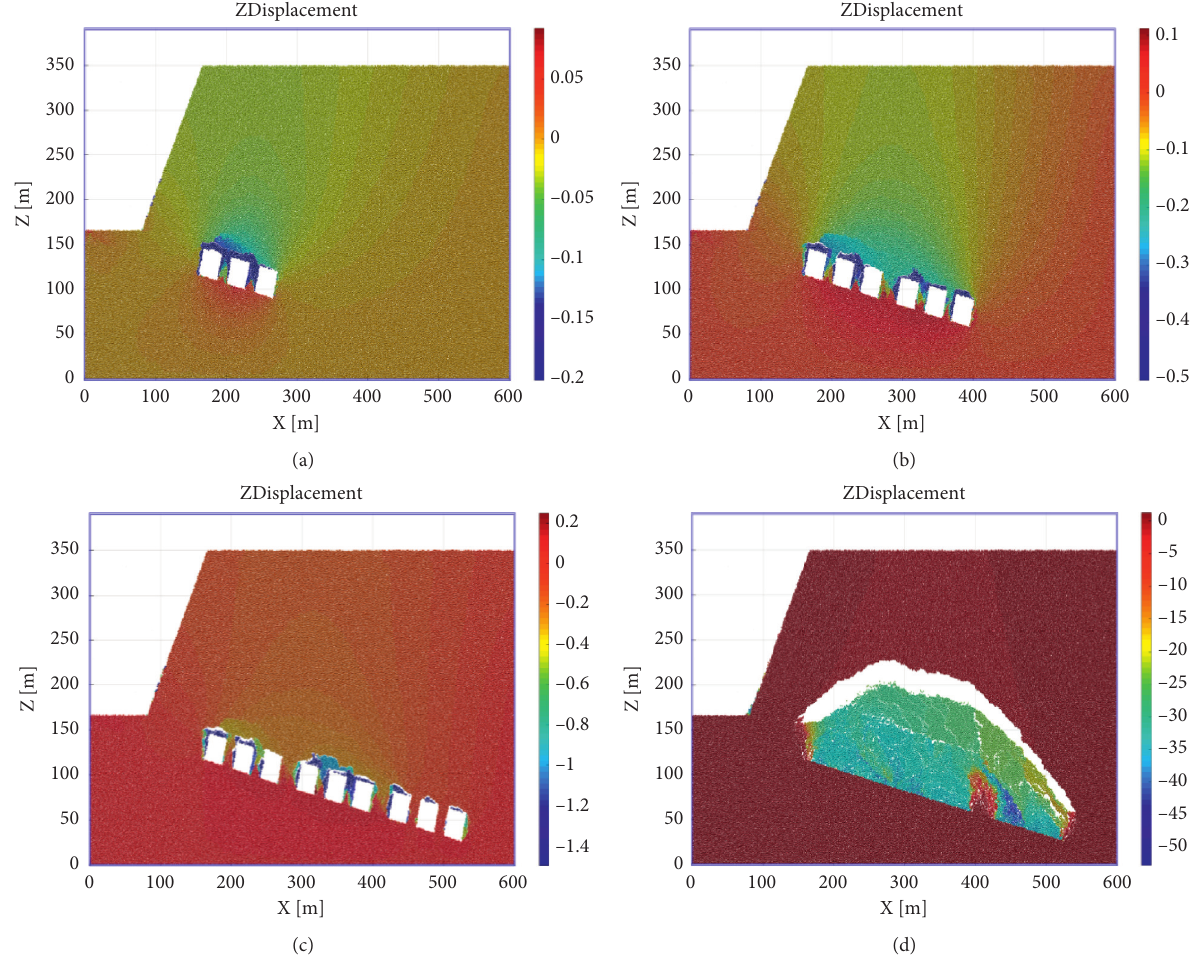
Figure 11: Displacement distribution of excavated rock mass in (a) the first stage, (b) the second stage, (c) the third stage, and (d) the stoping